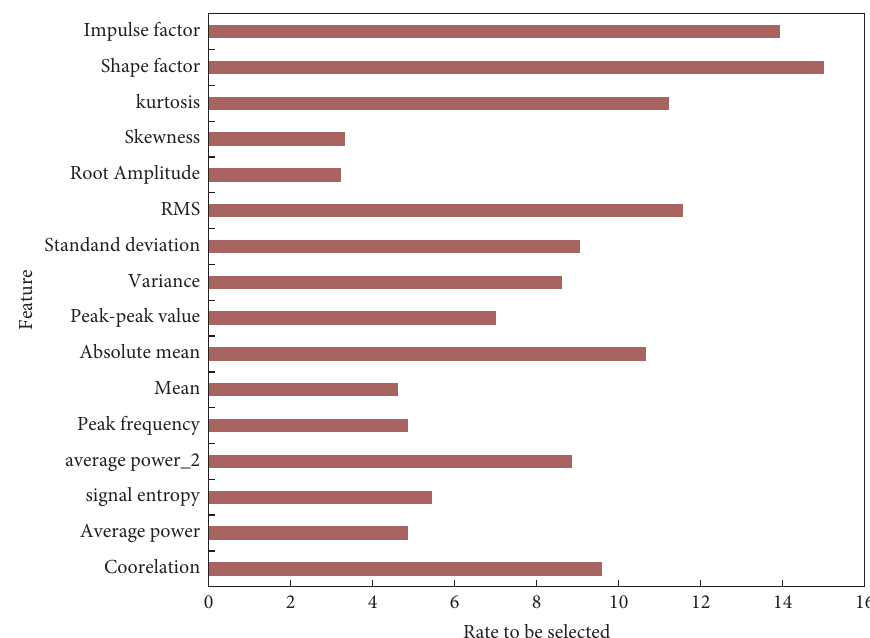
Figure 4: Frequency distribution of the best feature selected by the attribute selector.